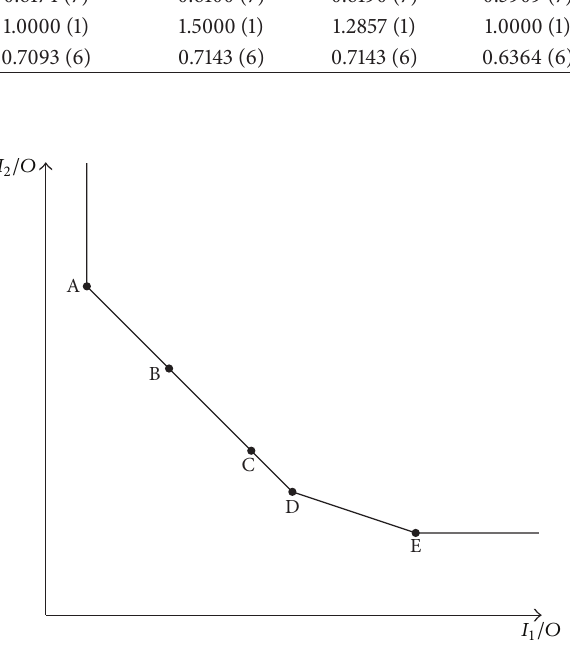
Figure 1: Farrell frontier for five